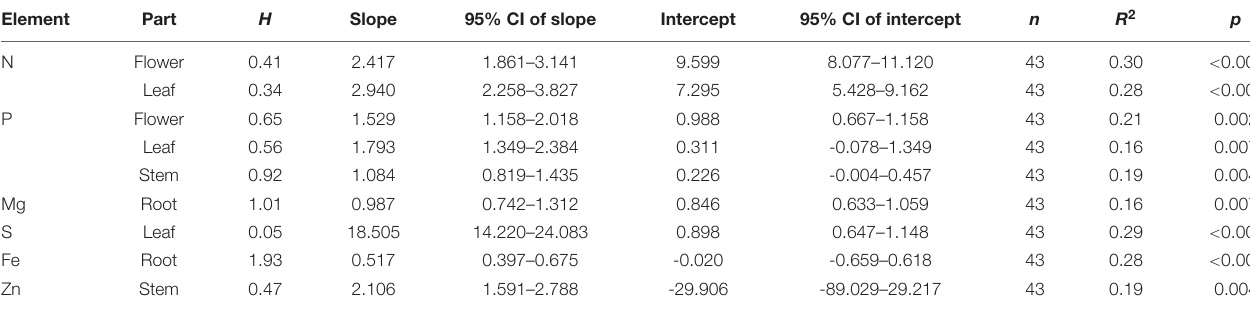
TABLE 4 | Parameters of relationships between soil elements contents and plant elements contents. Element Part Slope 95% CI of